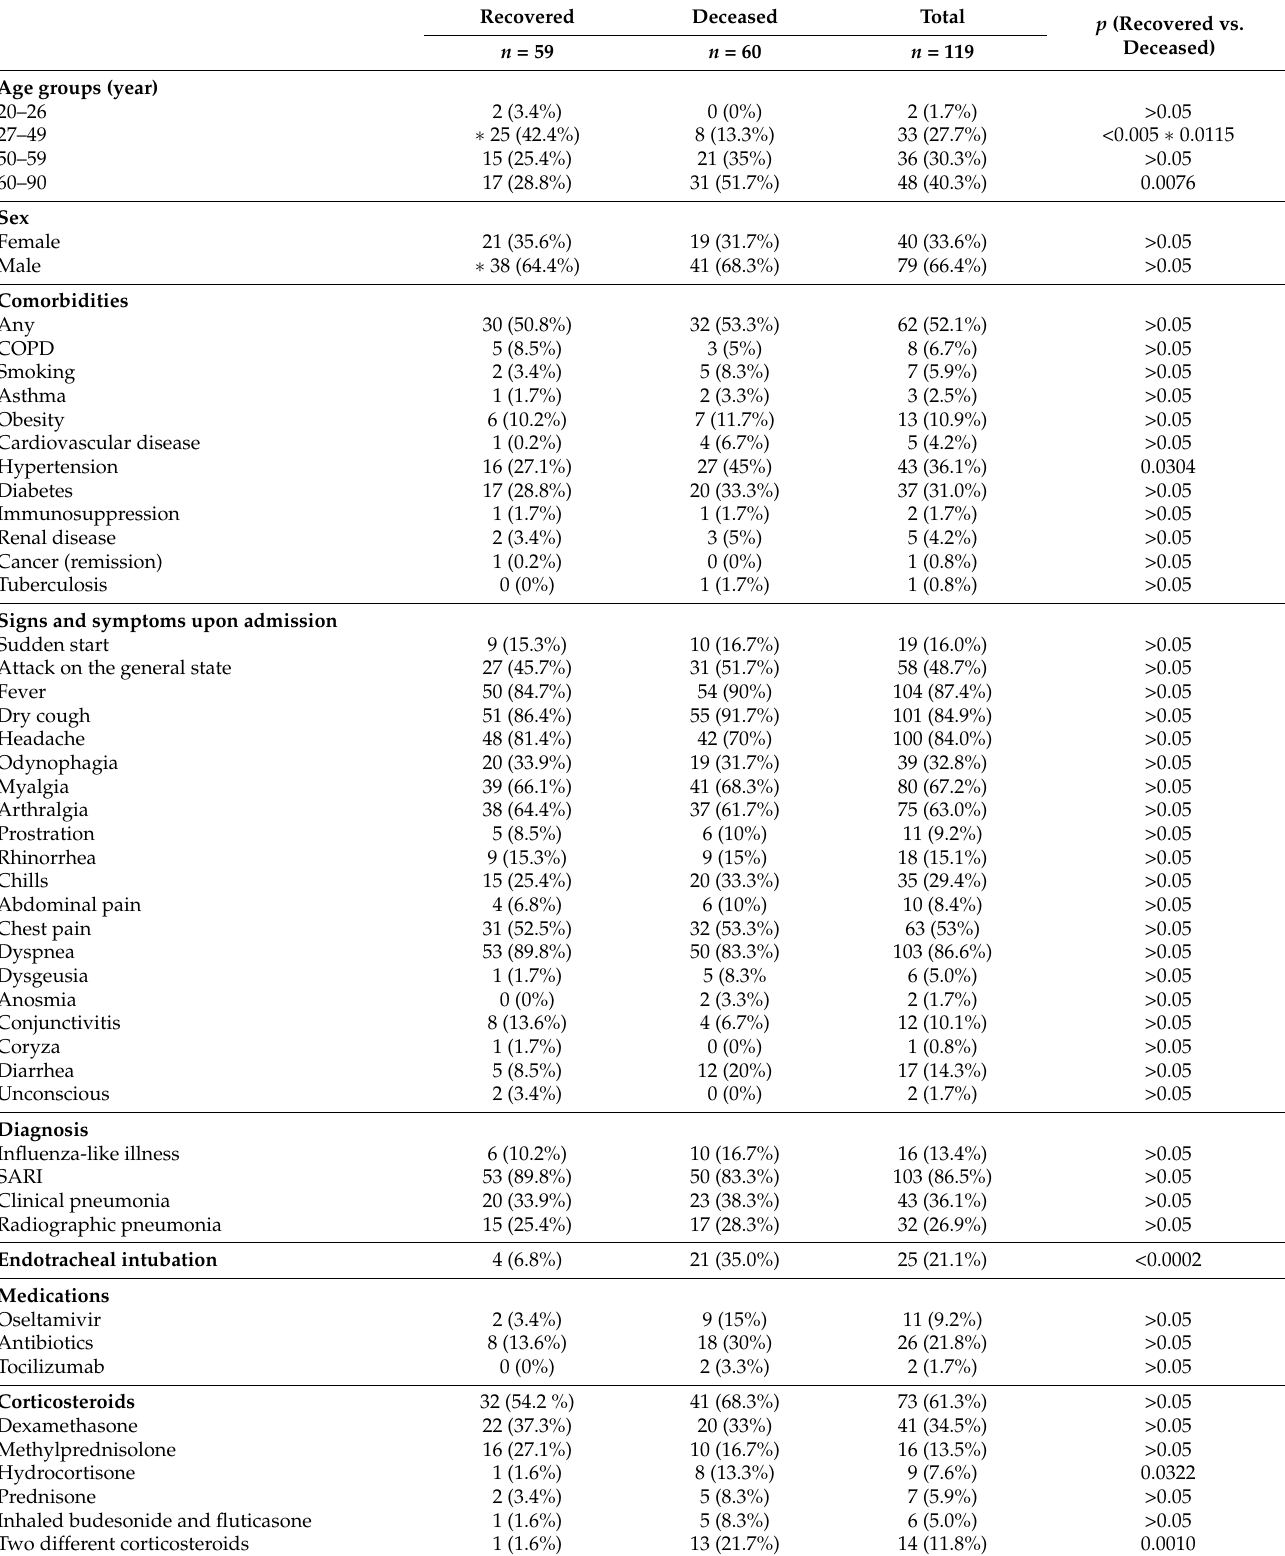
Table 1. Demographics, baseline characteristics, and diagnoses of the patients, classified according to the